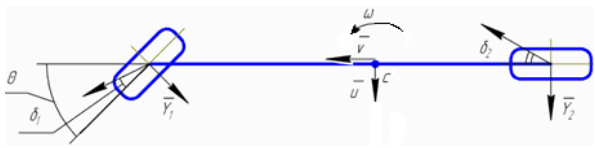
Figure 1. The vehicle’s